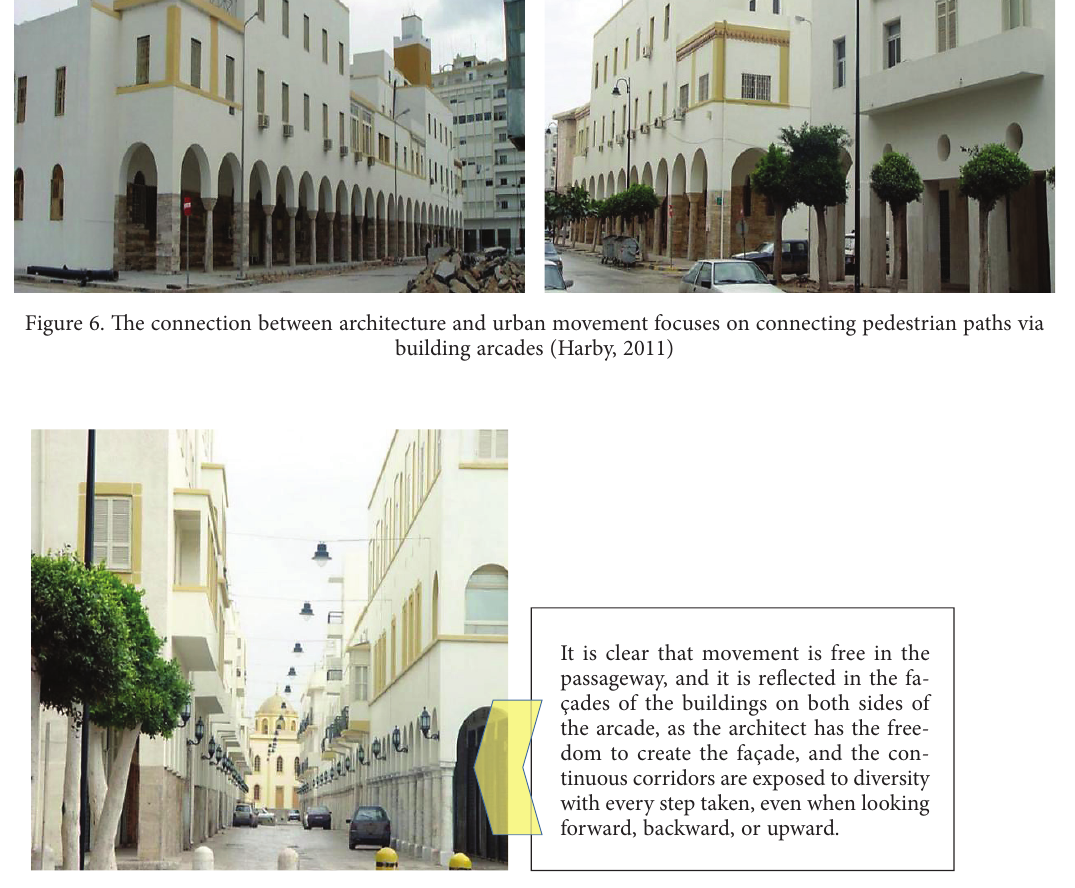
Figure 7. Th e Photographic Image shows the Major Axis of the Baladiya Piazza (Th e presence of retail confi rms its hierarchical value) (Harby,